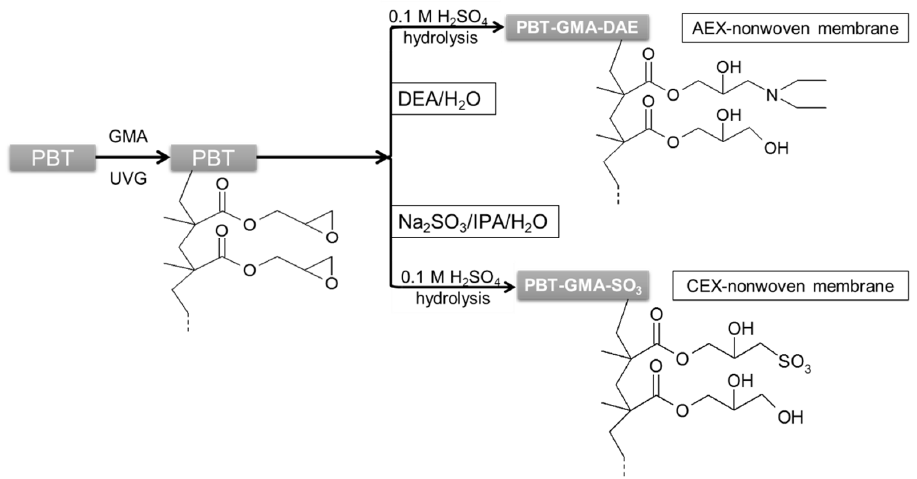
Figure 1. Schematic representation of ion-exchange PBT nonwoven membrane preparation chemistry.